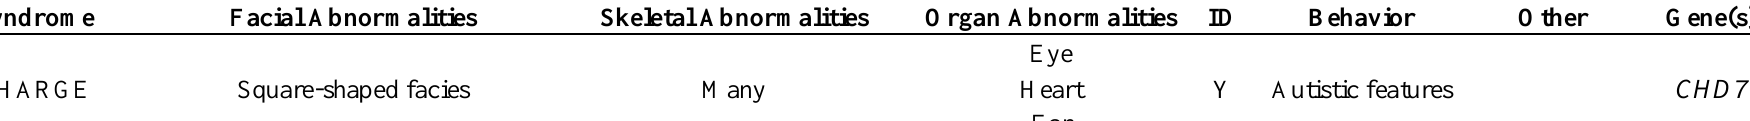
Table 3. Developmental disorders linked to cofactors bound to super-enhancers as identified by